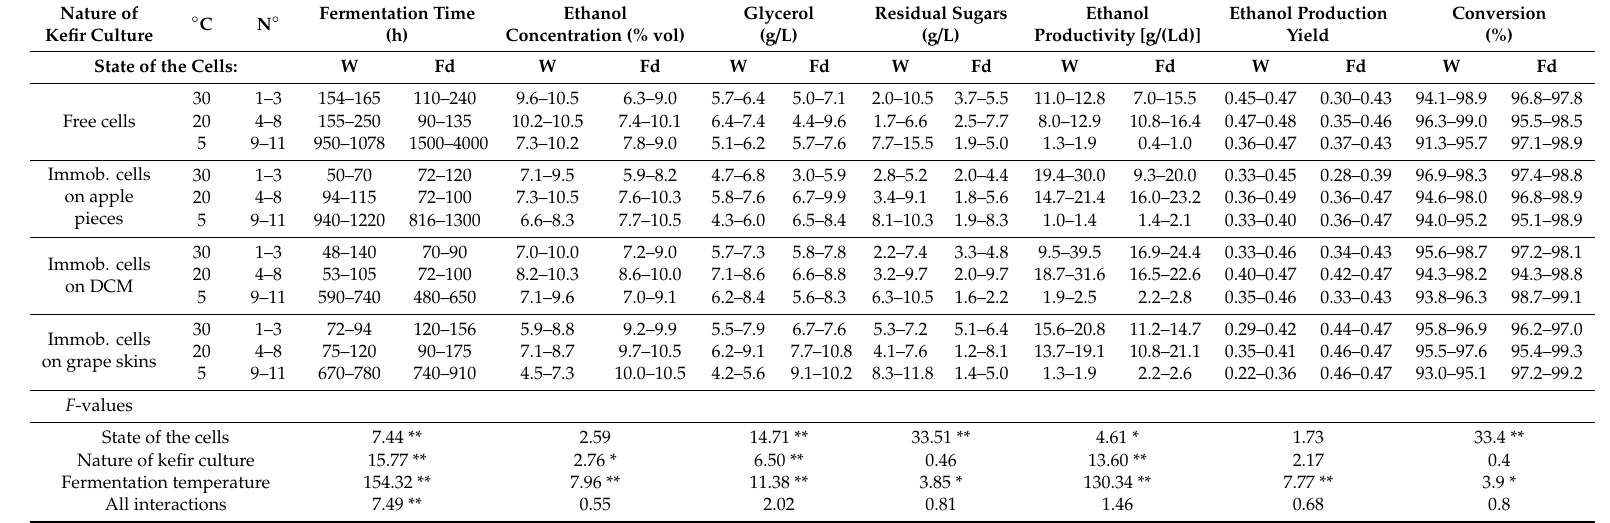
Table 2. Fermentation parameters of low alcohol wines produced by repeated batch fermentations at 5–30 ◦ C using wet or freeze-dried kefir